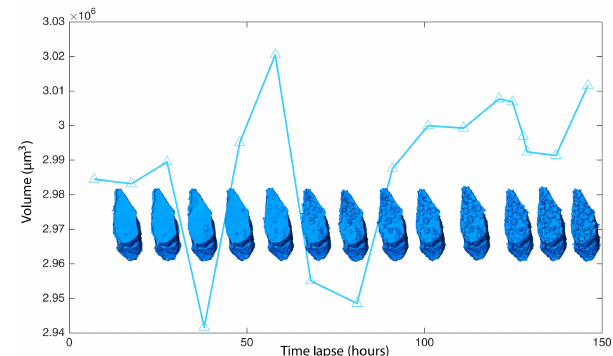
Figure 13. Volume change of an individual olivine grain (total vol- ume of olivine and precipitates) during carbonation reaction in the SGC experiment. The precipitates are idiomorphic and referred to as magnesites (see Zhu et al., 2016). This observed volume change results from a combination of the dissolution of olivine and precip- itation of magnesites. Fluctuations of the grain volume manifest the altering dominance of dissolution versus